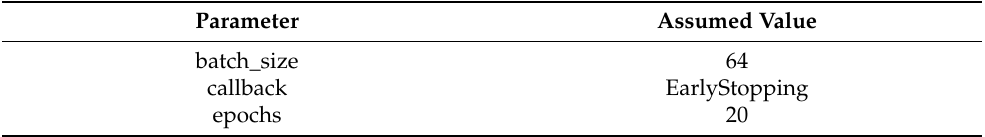
Table 4. Deep learning hyperparameters